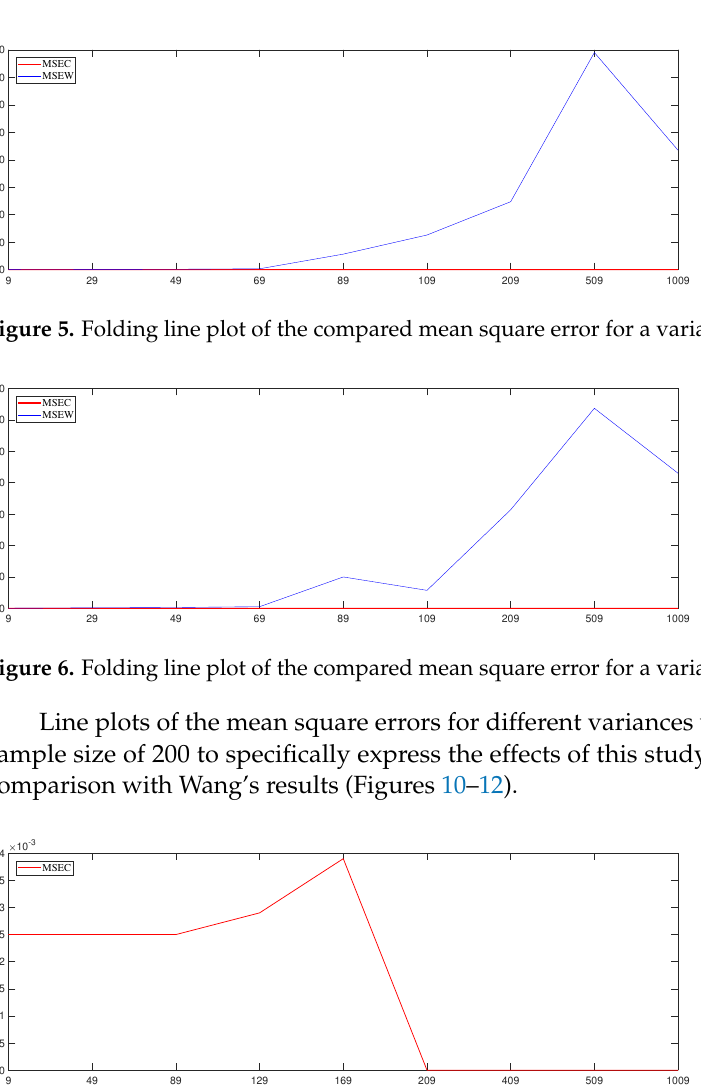
Figure 4. Folding line plot of the compared mean square error for a variance of 0.5.